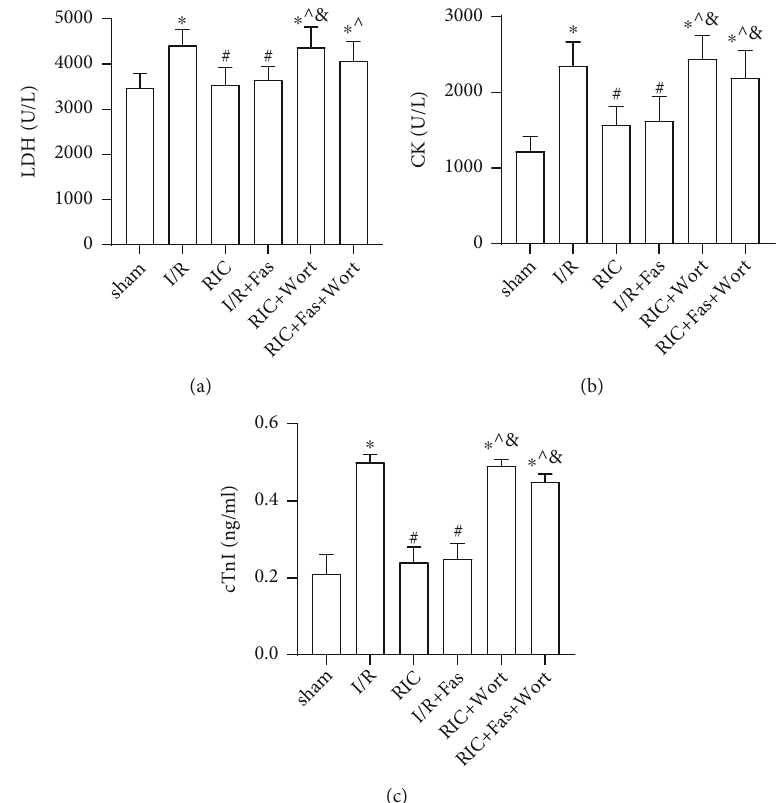
Figure 3: Changes in plasma LDH (a), CK (b), and cTnI (c) in the di ff erent groups. LDH: lactate dehydrogenase; CK: creatine kinase; cTnI: cardiac troponin; Data are presented as the mean ± SD ( n = 10 ). ∗ P < 0 : 05 vs. sham group; # P < 0 : 05 vs. I/R; ^ P < 0 : 05 vs. RIC; & P < 0 : 05 vs. I/R+Fas